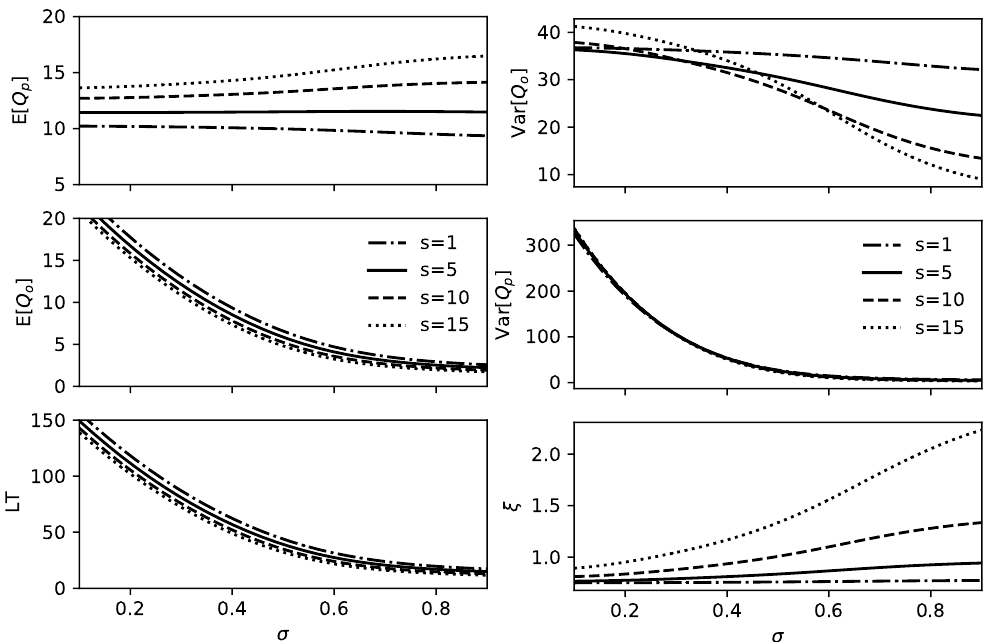
Figure 3. Mean of the order backlog, the inventory level and the lead time vs. the arrival parameter σ for different values of the threshold s ( left ) and variance of the inventory level and order backlog and setup rate vs. the arrival parameter σ for different values of the threshold s ( right